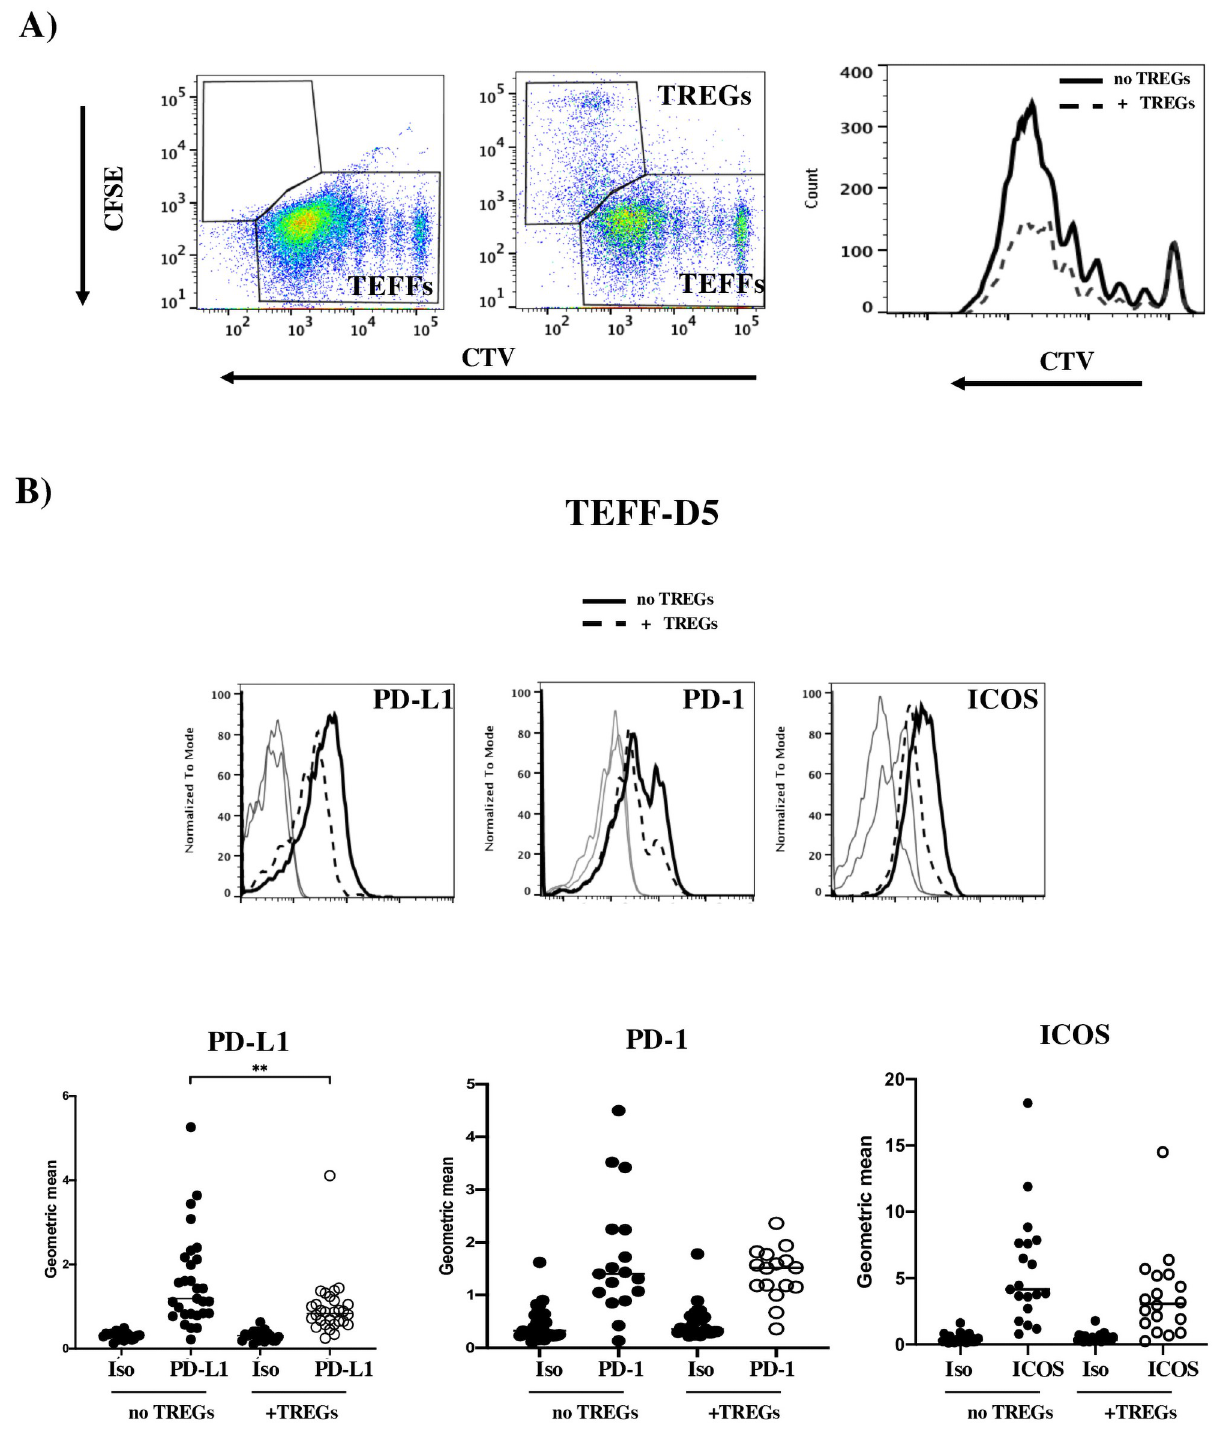
Fig 3. PD-L1 expression on activated naive TEFFs is regulated by TREGs. A) Representative flow cytometry dot plots and histograms for the proliferation of CTV-stained TEFFs on D5 of co-culture, in the absence of TREGs (left dot plot and the solid black line on the histogram) or in the presence of CFSE-stained TREGs with a TEFF:TREG ratio of 1:0.5 (right dot plot and the dashed black line on the histogram). B) Representative overlay histograms of different surface receptors in the absence (solid black lines) or presence of TREGs (dashed black line). The isotype control (Iso) is shown for each protein (solid grey lines). Lower panel: graphs of each respective marker’s geometric mean fluorescence intensity in independent experiments (n = 8 to 25). �� p � 0.01 in an M-W test. Bars represent the means of all experiments for each proteins.